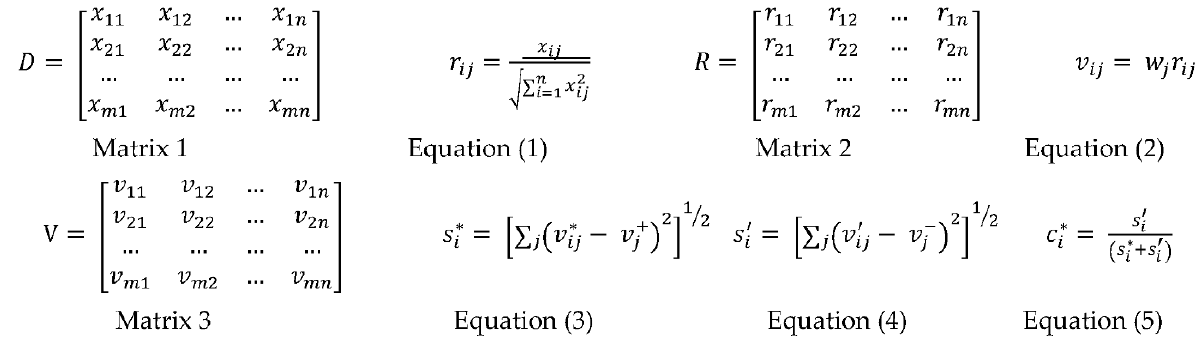
Figure 2. Equations and matrices are used in the steps of the TOPSIS technique. Source: Adapted from [86].